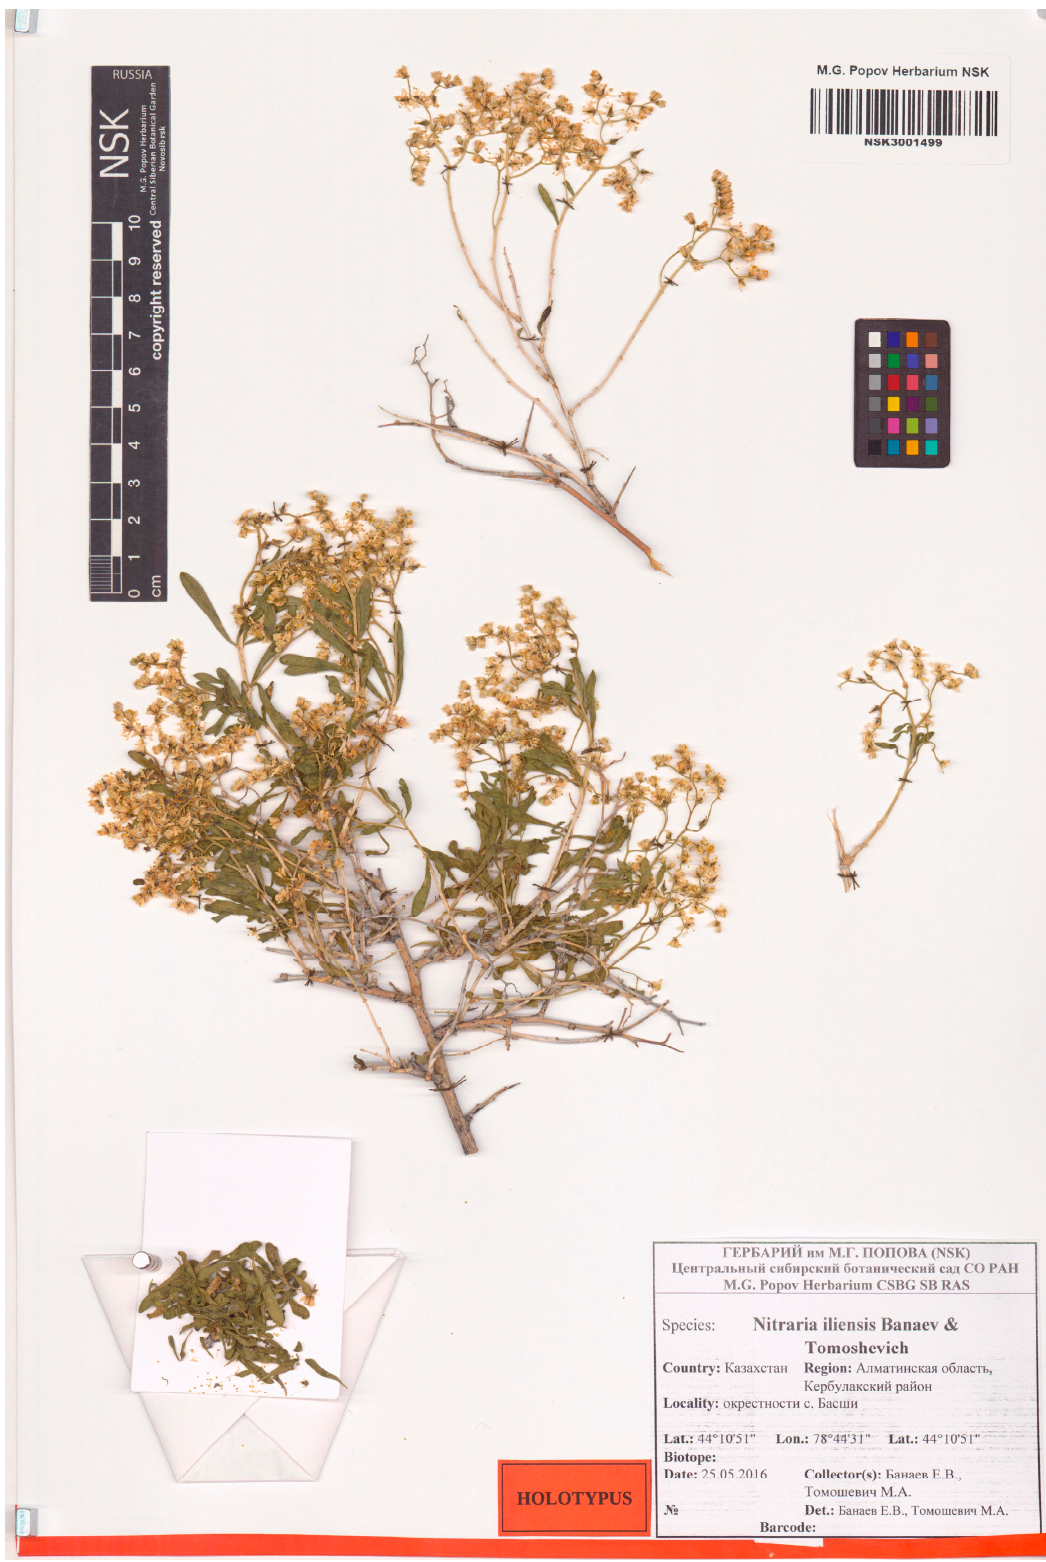
Figure 6. Holotype of N. iliensis Banaev & Tomoshevich, sp. nov. (NSK 3001499). Paratype Republic of Kazakhstan, Almaty region, vicinity of Basshi village, 44°10 ′ 51 ′′ N, 78°44 ′ 31 ′′ E, 1021 m a.s.l., 30 July 2013, E. V. Banaev & M. A. Tomoshevich (NSK3001277) (Figure 7).